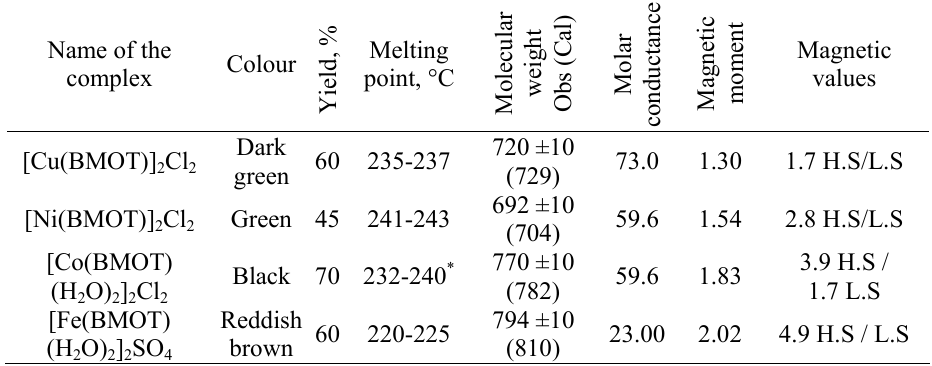
Table 1. Physical, molar and magnetic properties of BMOT complexes